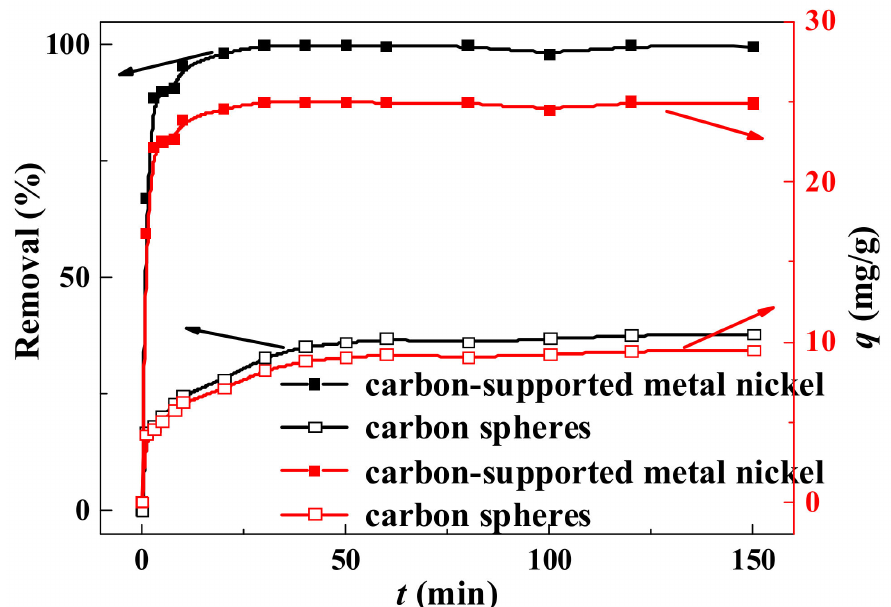
Figure 7. Effect of contact time on the removal of reactive brilliant yellow R-4GLN over carbon spheres and carbon-supported metal nickel.